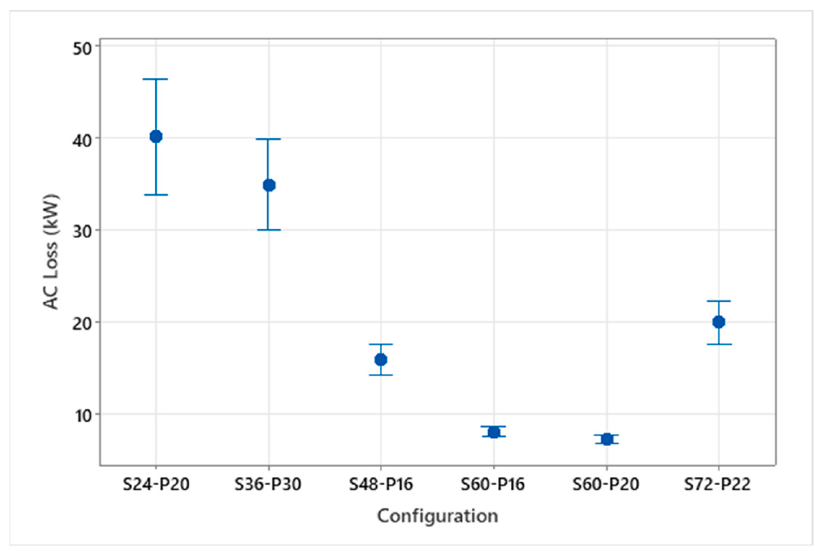
Figure 3. AC to DC loss ratio for the PM-to-airgap ratio